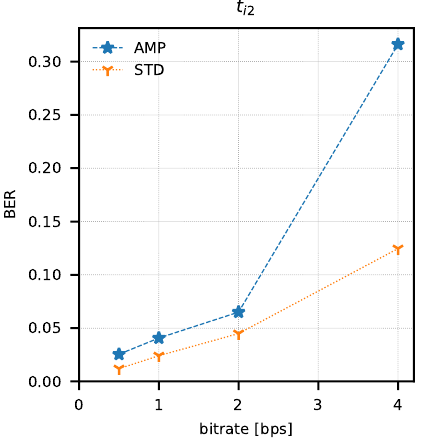
Figure 15. Bit error rate values as a function of bit rate and analysis method (AMP—amplitude analysis, STD—variance analysis) for t i 2 integration time set.